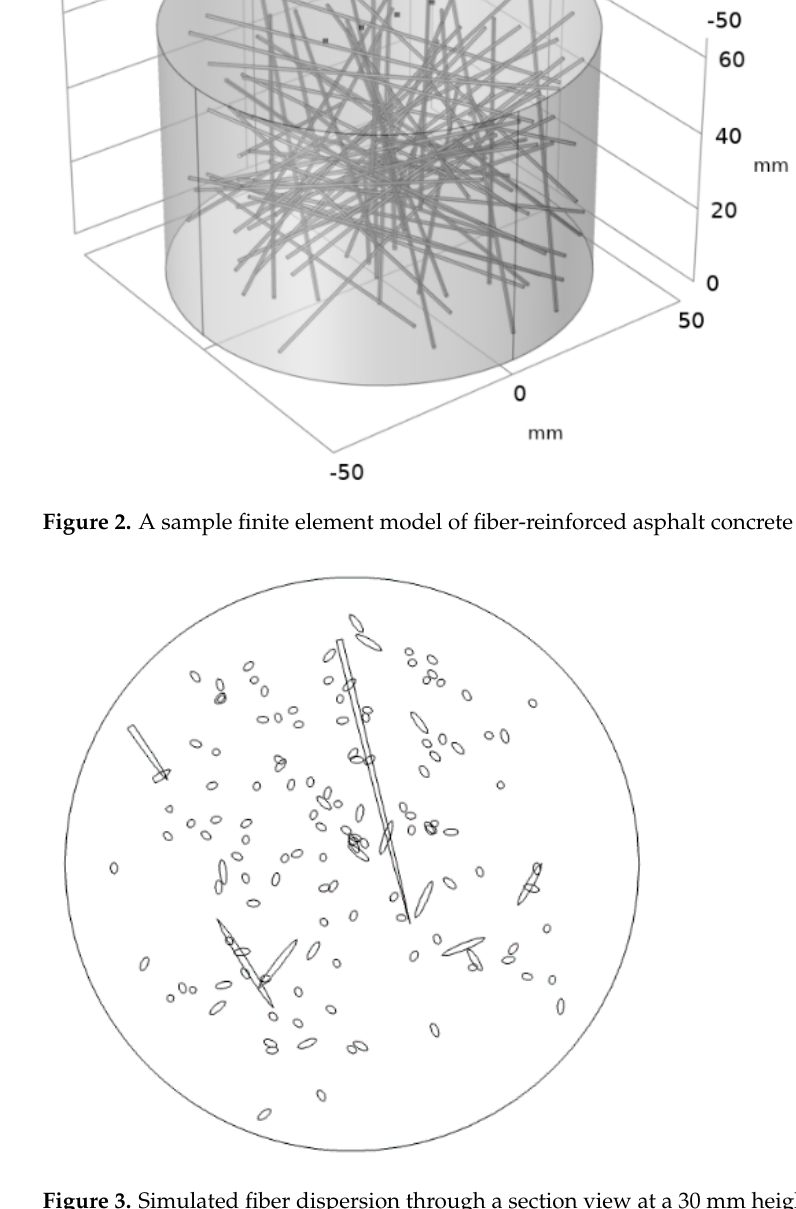
Figure 2. A sample finite element model of fiber-reinforced asphalt concrete prototype. Table 2. Dimensions of fibers.